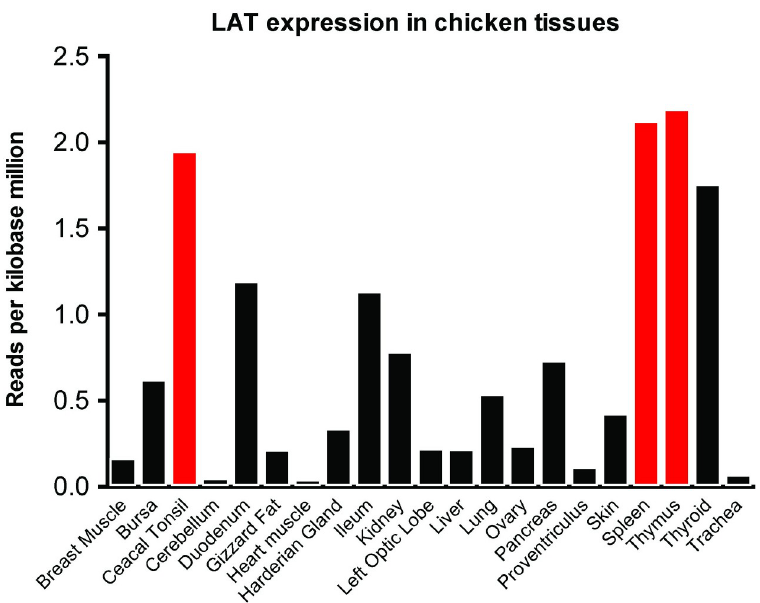
Fig 4. Expression of cLAT is enriched in immune-related organs. The expression levels of cLAT mRNA was determined in silico from SRA data (see Methods). Immune-related organs are depicted by red bars.